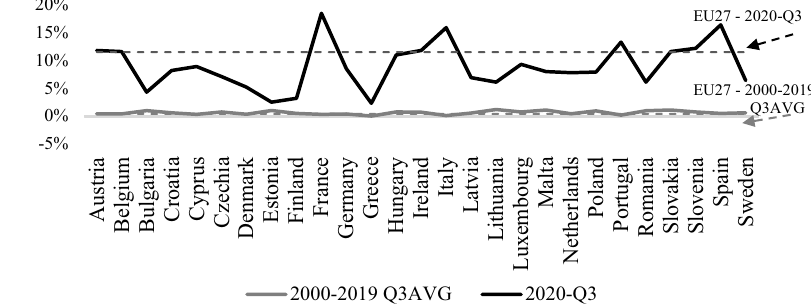
Figure 6: Q3 - GDP evolution for EU 27 countries. Source: Authors ’ elaboration based on data from Eurostat.